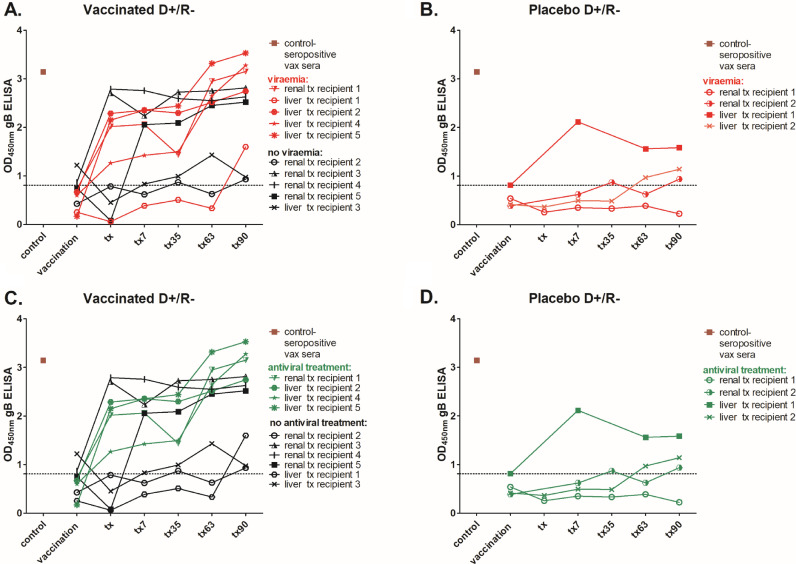
A prompt post-transplant increase in antibody levels against glycoprotein B is not explained by either low level or high level viraemia.Total anti-gB antibody levels were measured by standard ELISA and are shown for individual patients. A-B) Patients were stratified for viraemia (red) versus non-viraemia (black) in vaccinated (A; n = 10) and placebo recipients (n = 4; B). C-D) Alternatively, vaccine (C) or placebo (D) patients were stratified by requirement for antiviral treatment (viraemia exceeding 3000 genome copies/ml) and are depicted in green: Serum samples were collected at the time of vaccination time of transplantation and on days: 7, 35, 63 and 90 post-transplant. Dashed line represents the cut off and was informed by control sera taken from healthy seronegative individuals (n = 6). (For interpretation of the references to color in this figure legend, the reader is referred to the web version of this article.)